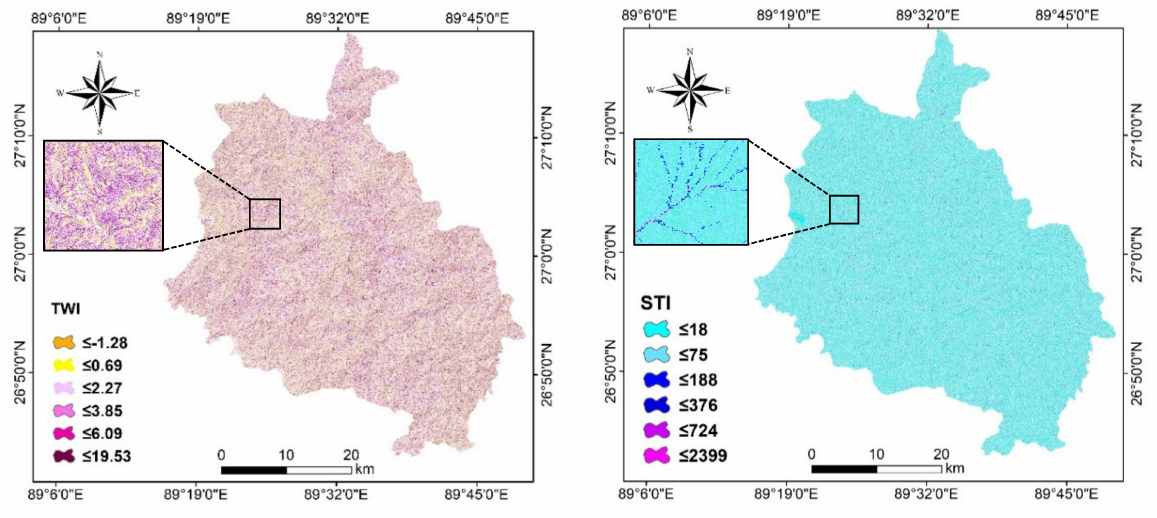
Figure 2. Landslide conditioning